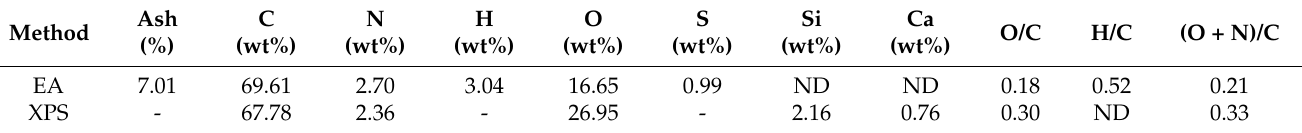
Table 1. Elemental composition, atomic ratio, and polar index of nano-BC by elemental analysis (EA) and XPS. Method